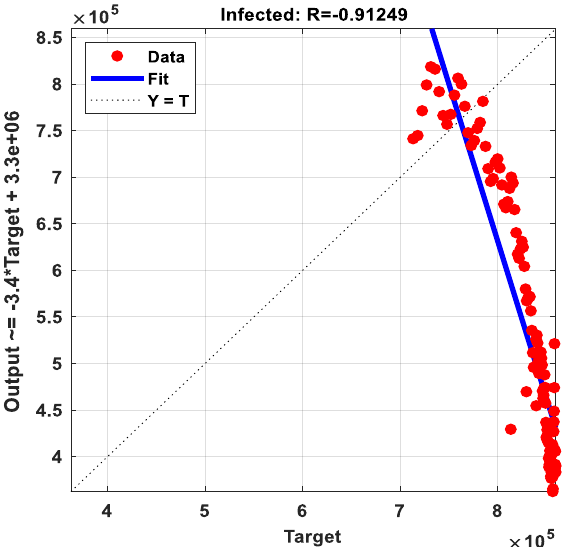
( a ) The correlations coefficients and the linear regression equations between the observed infected values and the target values (PPA-BMLPNN model values) for Brazil. Figure 6. Cont